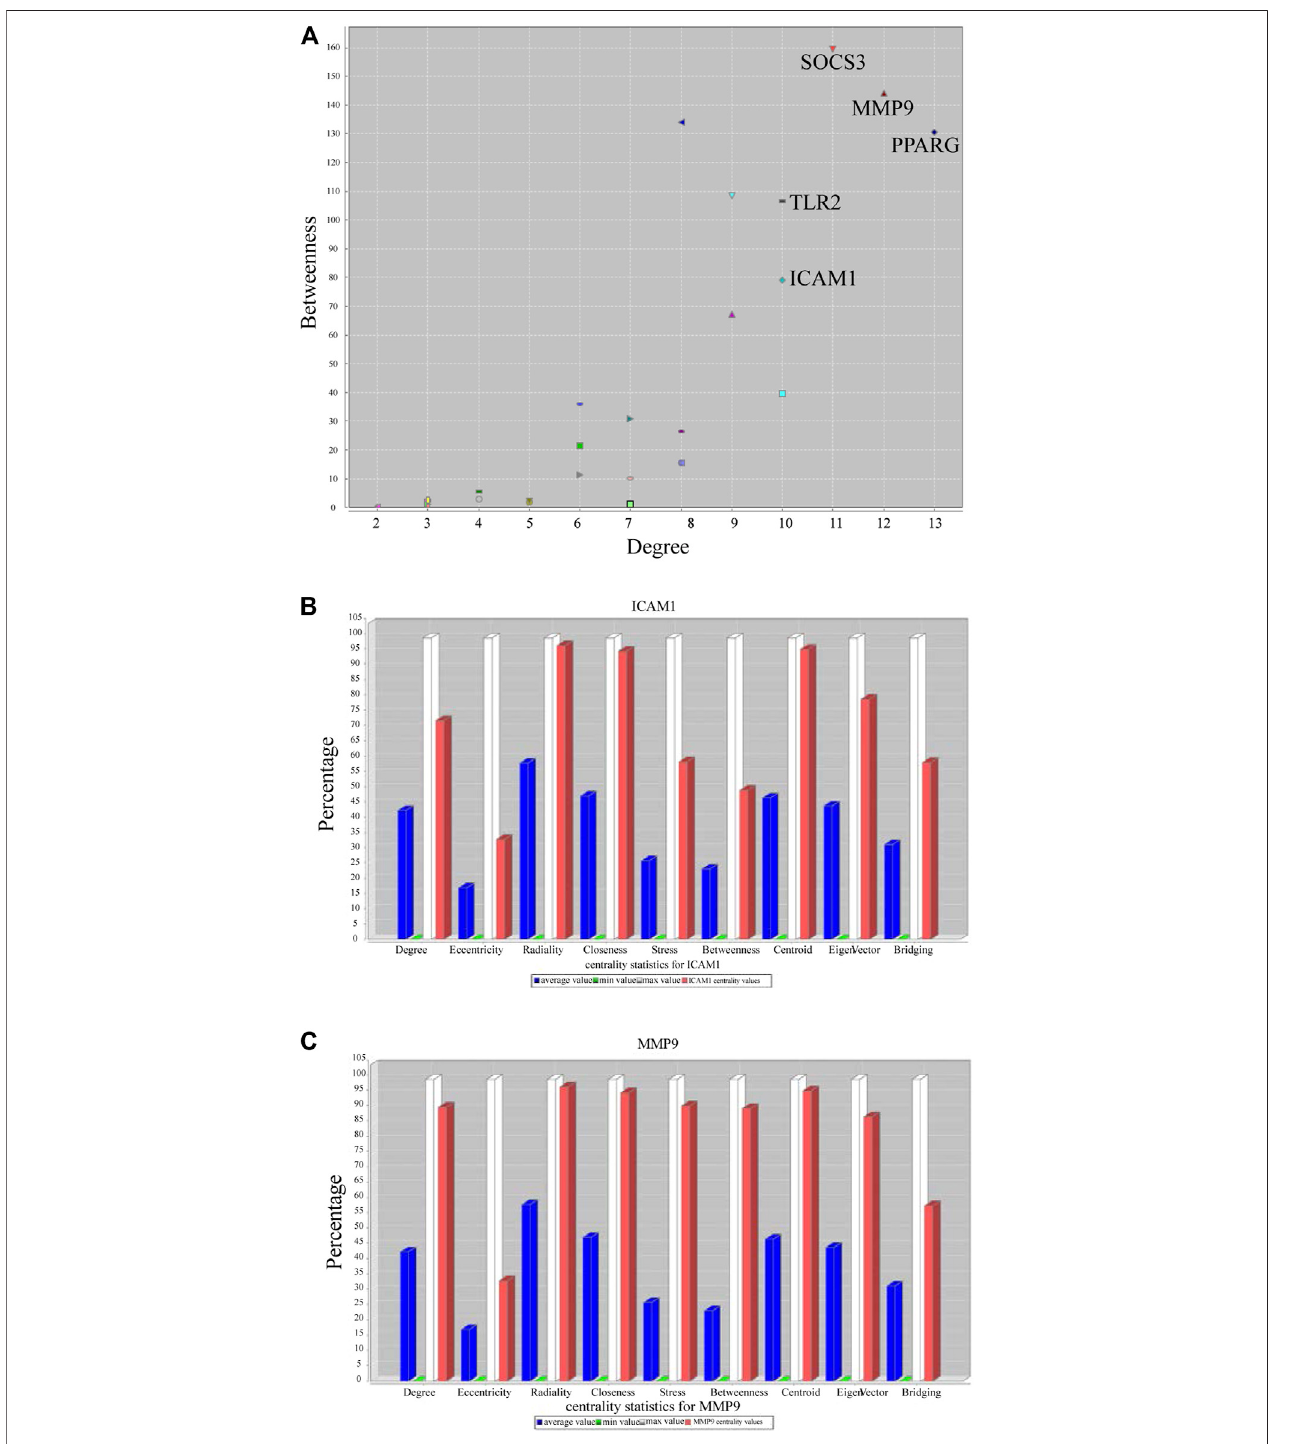
FIGURE 4 | Topological result of GA targets on COVID-19. (A) The ordinate indicates the degree, and the abscissa indicates the degree of betweenness (B) Network topology analysis parameter of ICAM1. (C) Network topology analysis information of MMP9.